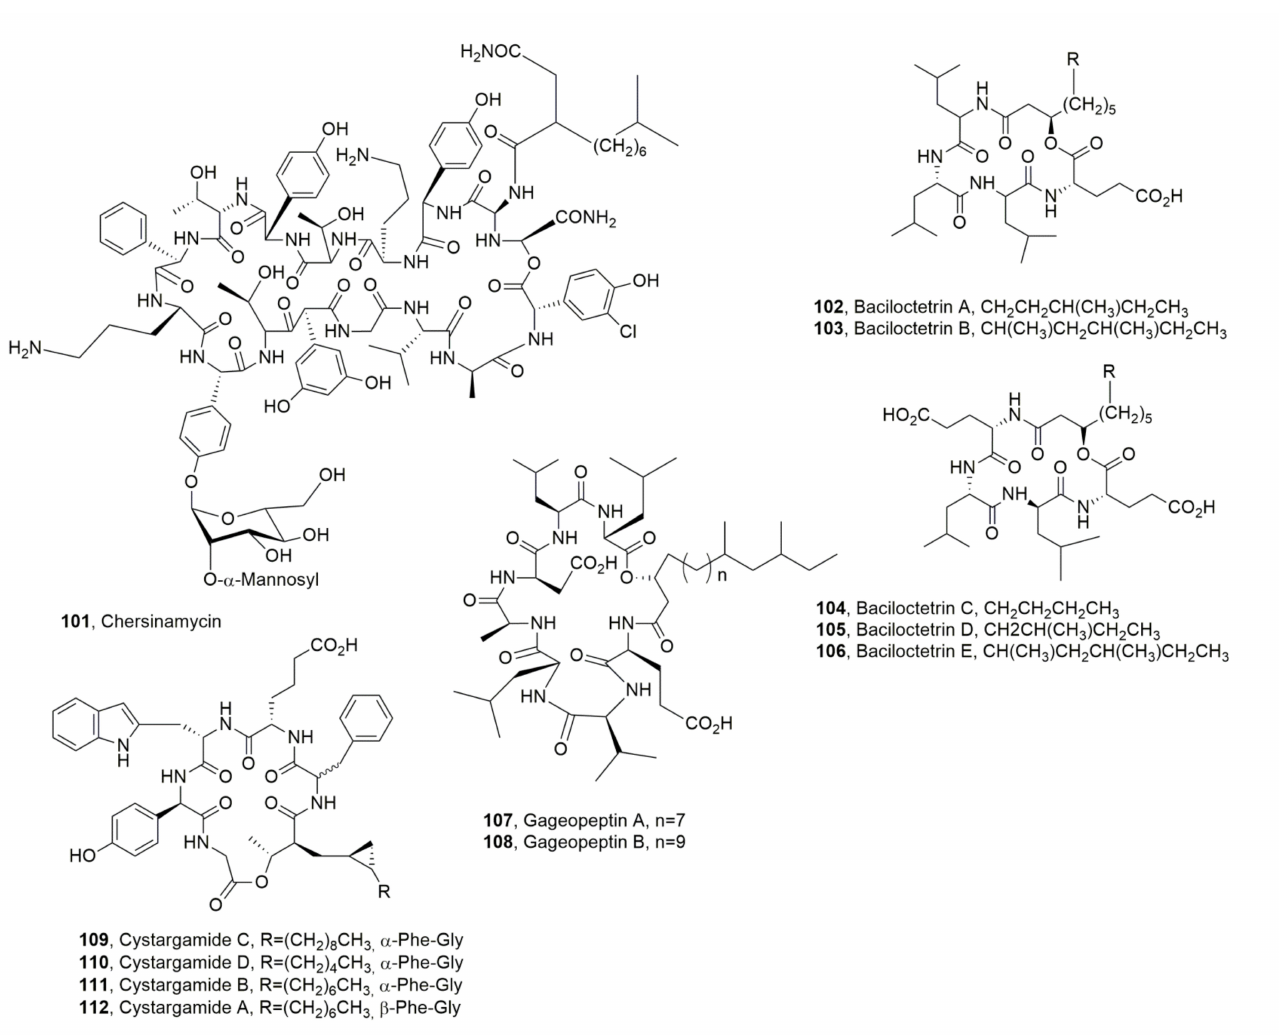
Figure 12. Structures of lipodepsipeptides produced by Micromonospora chersina ( 101 ), Bacillus subtilis ( 102 – 108 ), and Streptomyces sp. ( 109 – 112 ). Baciloctetrins A and B ( 102 and 103 , Figure 12) were produced by B. subtilis